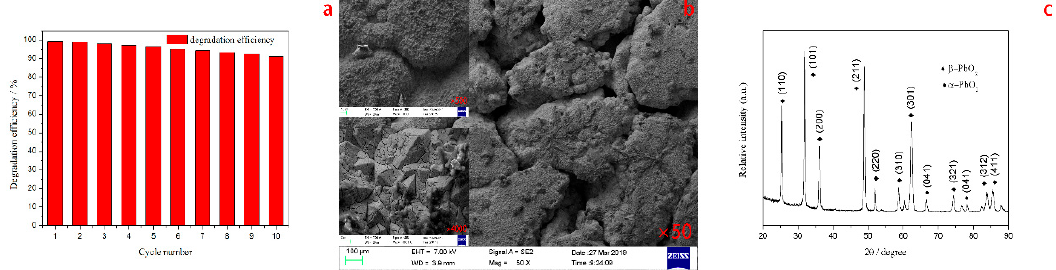
Figure 12. ( a ) Change in chloride removal rate of a porous Ti / SnO 2 –Sb 2 O 3 / PbO 2 electrode during ten successive removal cycles; ( b ) Scanning electron microscopy (SEM) pattern of the porous Ti / SnO 2 –Sb 2 O 3 / PbO 2 electrode after recycling; ( c ) X-ray di ff raction (XRD) pattern of the porous Ti / SnO 2 –Sb 2 O 3 / PbO 2 electrode after recycling.